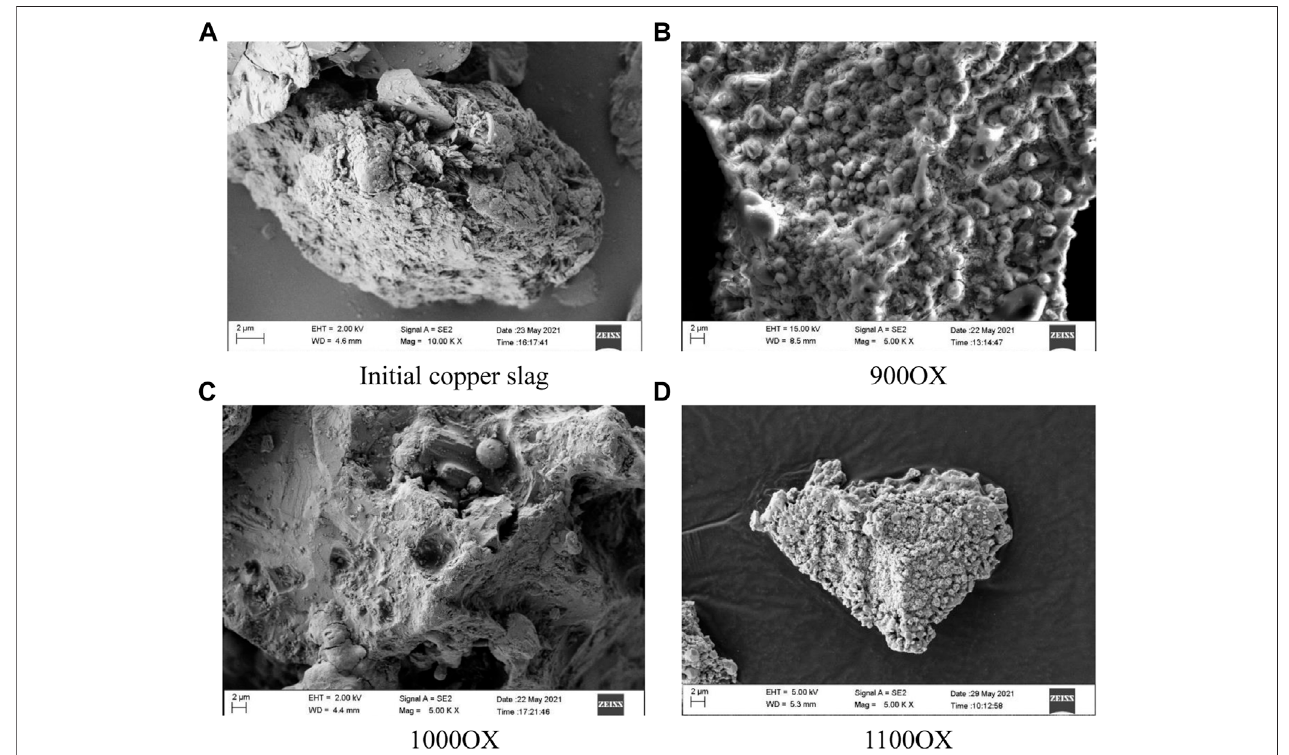
FIGURE 3 | SEM diagrams of copper slag. (A) Initial copper slag. (B) 900OX. (C) 1000OX. (D) 1100OX.